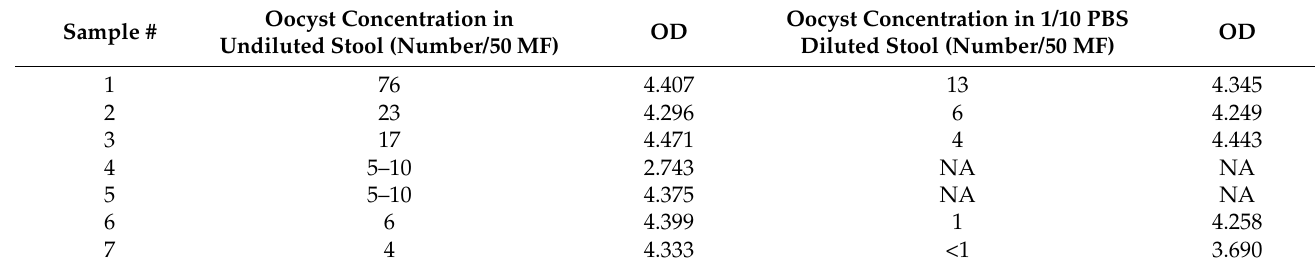
Table 2. Influence of stool oocyst concentration on ELISA antigen detection.